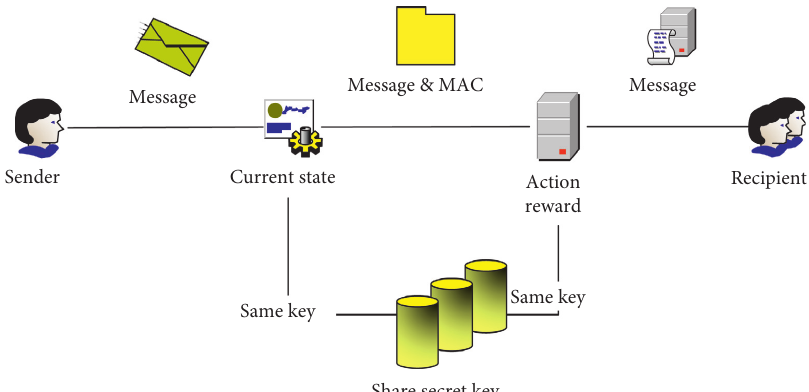
Figure 2: Network virtualization environment resource